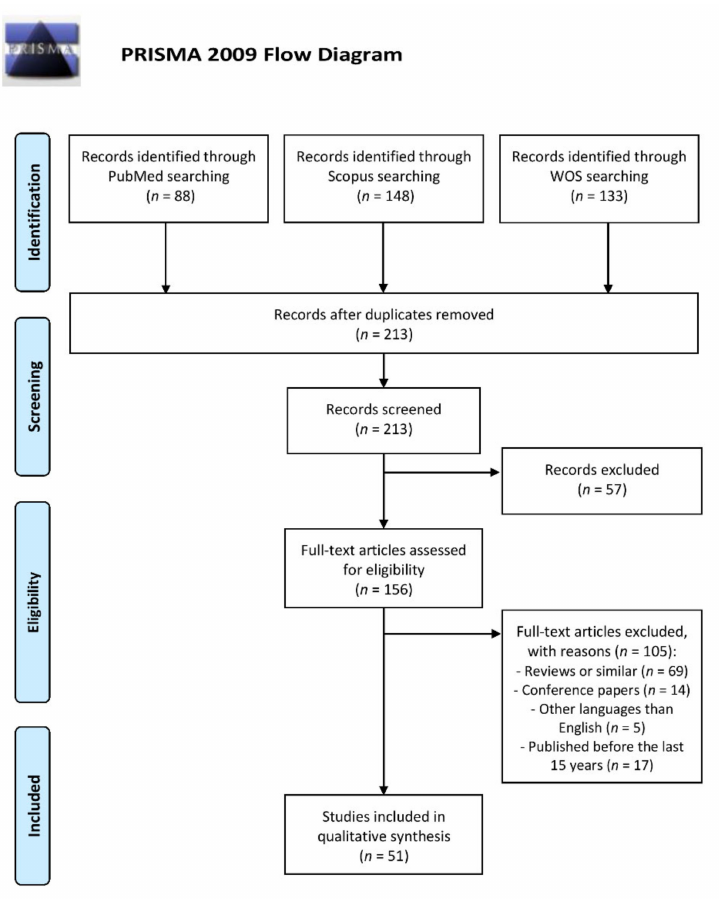
Figure 1. Flow diagram of the search and study selection performed according to the Preferred Reporting Items for Systematic Reviews and Meta-Analyses (PRISMA) statement. WOS, Web Of Sci-